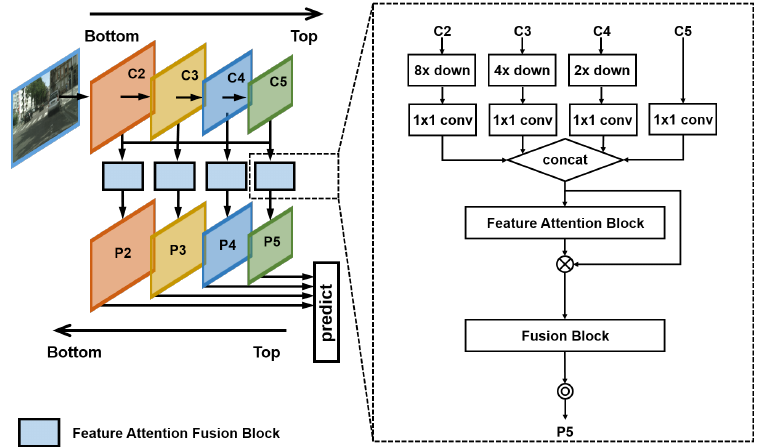
Figure 2. The architecture of our proposed Attention Pyramid Network (APN). A building